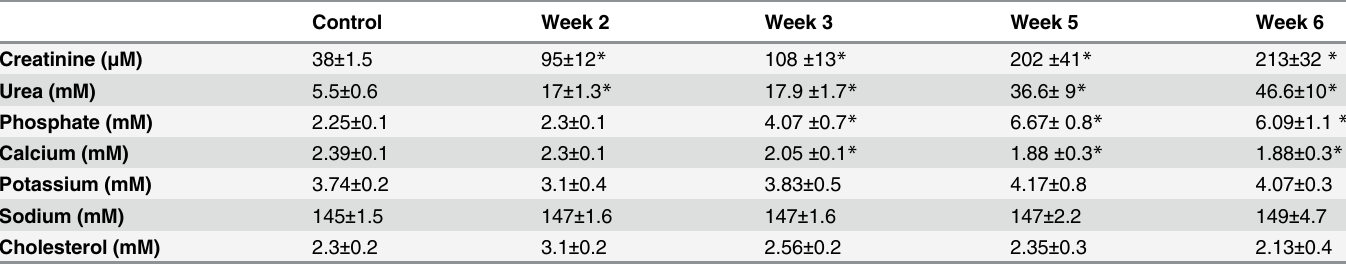
Table 1. Biochemical profile from rats at 2, 3, 5, and 6